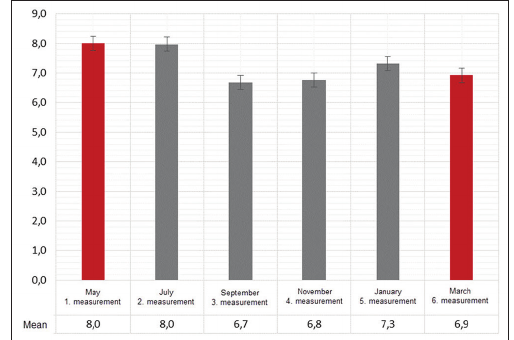
FIGURE 2. Depression in elderly people presented as a differ- ence between the 1 st and 6 th